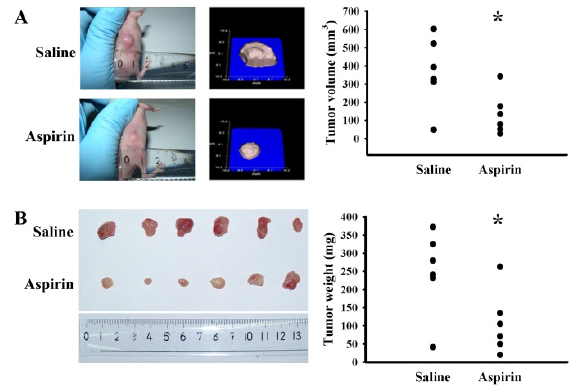
Figure 6. Aspirin mitigated tumor growth in mice. U87 cells were subcutaneously implanted into BALB/c nude mice. One week after implantation, aspirin (50 mg/kg) and saline vehicle were administrated daily via oral gavage for three weeks. ( A ) Tumor-bearing mice, tumor image obtained from Peira TM900 system, and tumor volume are shown. ( B ) The dissected tumor tissues and tumor weight are shown. * p < 0.05 vs. saline, n = 6.